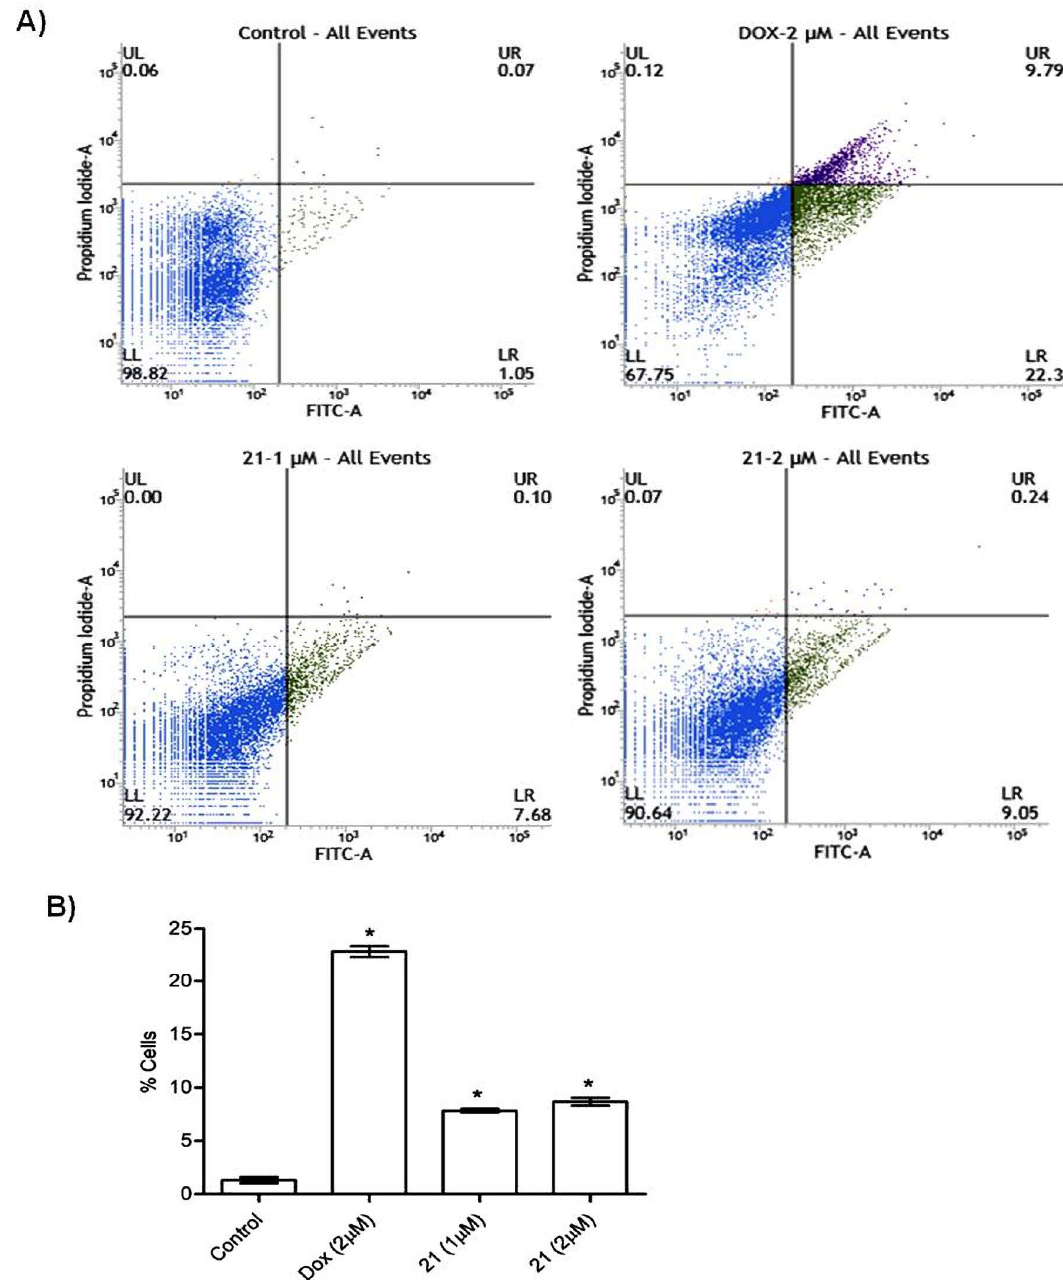
Figure 8. Annexin V-FITC assay in lung cancer cells A549; ( A ) Control cells and cells treated with Doxorubicin (2 µ M) and barbatic acid ( 21 ) at 1 and 2 µ M. Lower left (LL) represents live (viable) cells, lower right (LR) represents early apoptotic cells, upper right (UR) represents late apoptotic cells and upper left (UL) represents necrotic cells. ( B ) Bar graph indicating % apoptotic cells. Values are mean ± SD, n = 3. Tukey’s multiple comparison test followed by ANOVA was applied to compare the differences. * p < 0.0001 vs. control.